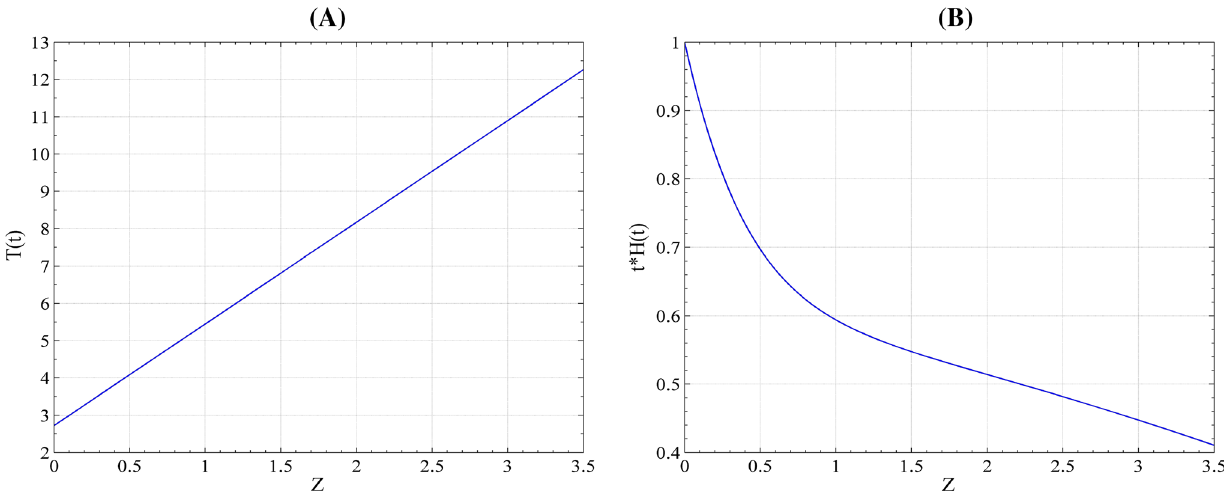
Fig. 2 Plots a and b indicate the temperature T ( t ) and t × H ( t ) versus redshift z at the redshift range [ 0 , 3 . 5 ] , respectively